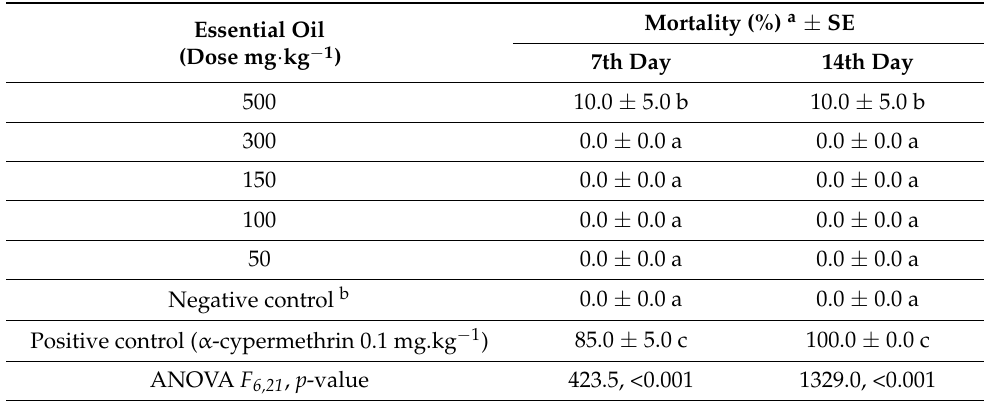
Table 3. Lack of toxicity of O. sanctum essential oil on non-target Eisenia fetida